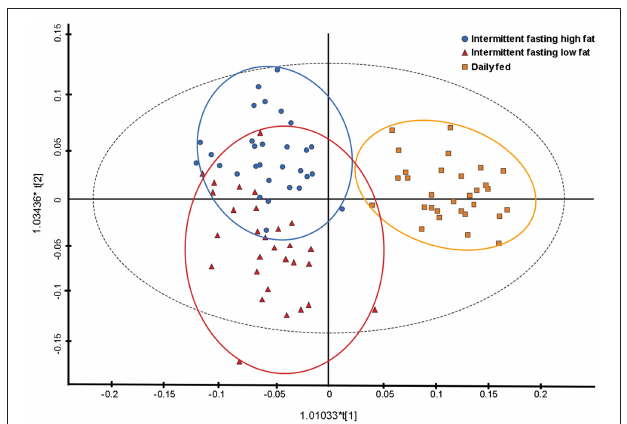
FIGURE 4 | Mean concentrations ( ± SE) of fasted plasma beta-hydroxybutyrate in 10 dogs fed daily (square), and intermittently fasted on a low fat (triangle) and a high fat diet (circle) in a Latin Square design. Lactate and Alanine via